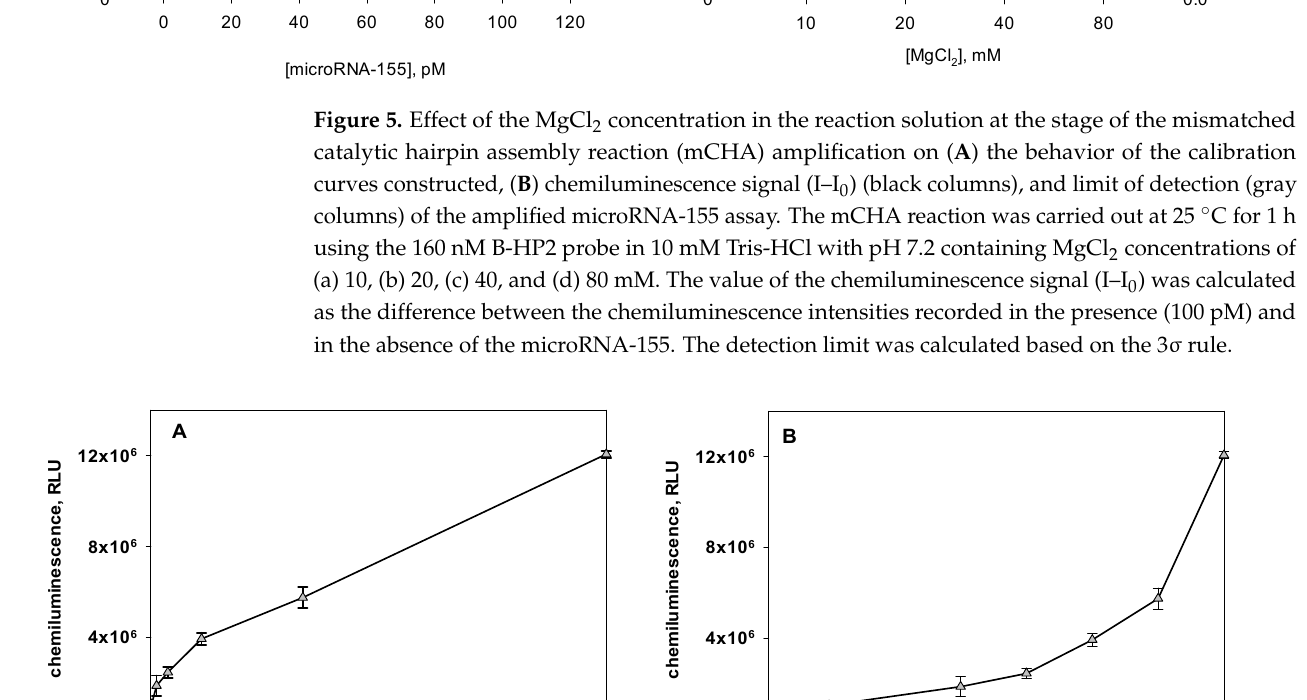
Figure 5. Effect of the MgCl 2 concentration in the reaction solution at the stage of the mismatched catalytic hairpin assembly reaction (mCHA) amplification on ( A ) the behavior of the calibration curves constructed, ( B ) chemiluminescence signal (I–I 0 ) (black columns), and limit of detection U (gray columns) of the amplified microRNA-155 assay. The mCHA reaction was carried out at 25°C L for 1 h using the 160 nM B-HP2 probe in 10 mM Tris-HCl with pH 7.2 containing MgCl 2 concentra- tions of (a) 10, (b) 20, (c) 40, and (d) 80 mM. The value of the chemiluminescence signal (I–I 0 ) was calculated as the difference between the chemiluminescence intensities recorded in the presence (100 pM) and in the absence of the microRNA-155. The detection limit was calculated based on the 3 σ rule.